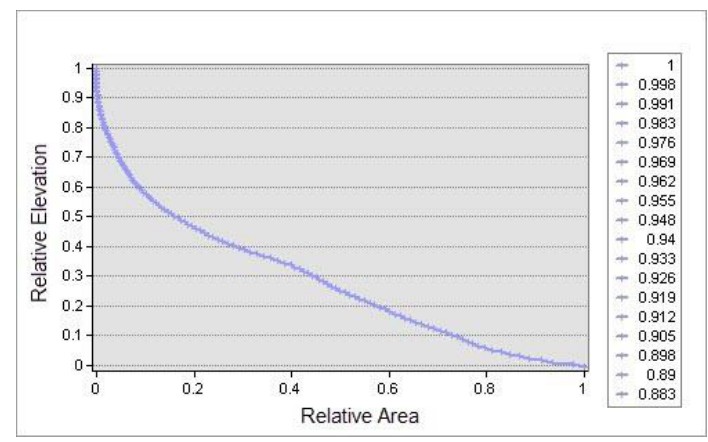
Figure 3. Hypsometric curve created for the sub-basin with the coast code 2 at first level of Western Mediterranean